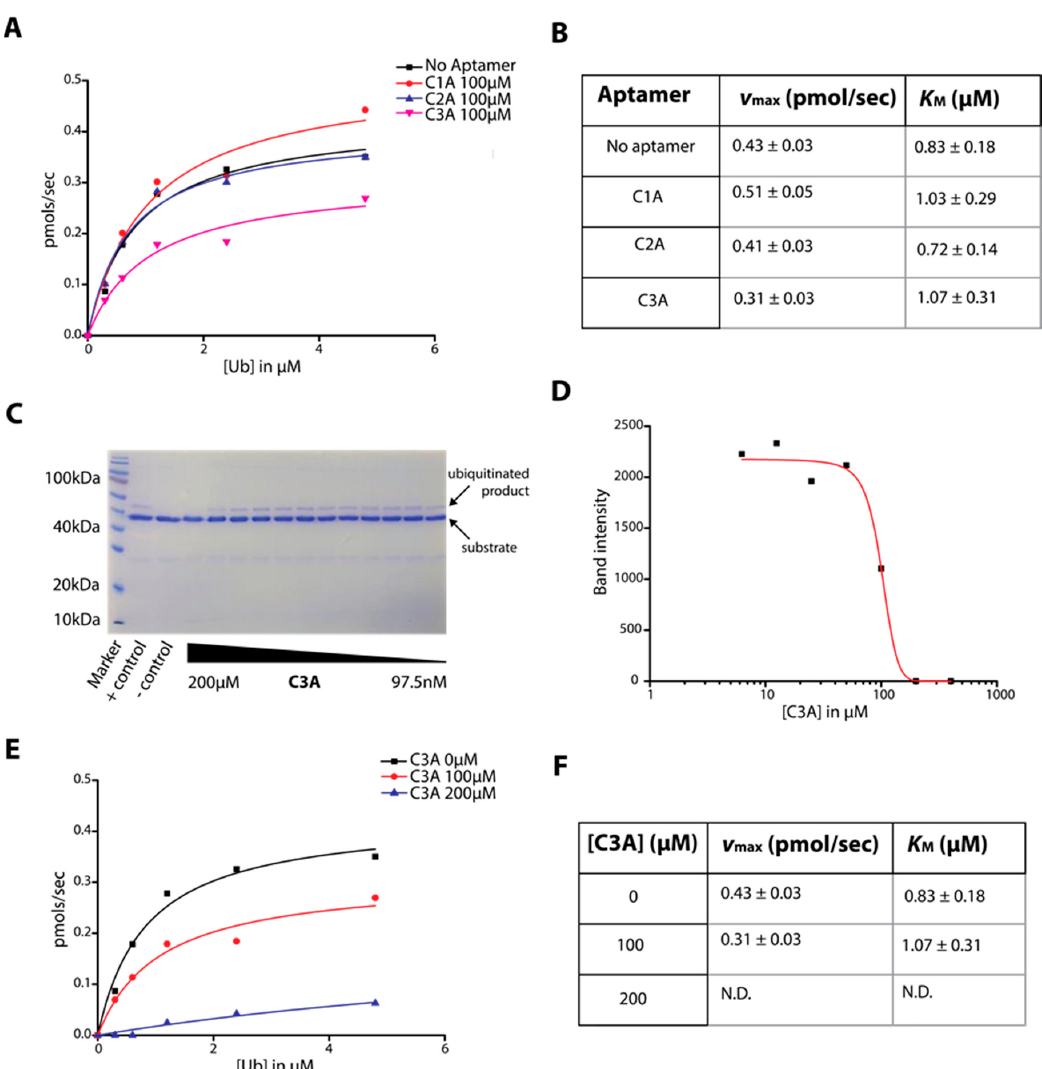
Figure 4. Aptamer mediated inhibition of HECT ubiquitination. ( A ) Rate of reaction product formation plotted against ubiquitin concentration (Michaelis-Menten) for aptamers C1A–C3A to compare inhibition rates between aptamers from representative gel data. ( B ) Resultant V max and K M values from the Michaelis-Menten plot. ( C ) 12% SDS-PAGE gel showing the reaction product over increasing C3A concentrations; ( D ) Logarithmic plot of C3A aptamer concentration to band intensity as measured to determine IC 50 from representative gel data ( E ) Michaelis-Menten plot of two different C3A concentrations for determination of mode of inhibition from representative gel data. ( F ) Summary of V max and K M values tabulated for the two C3A concentrations.